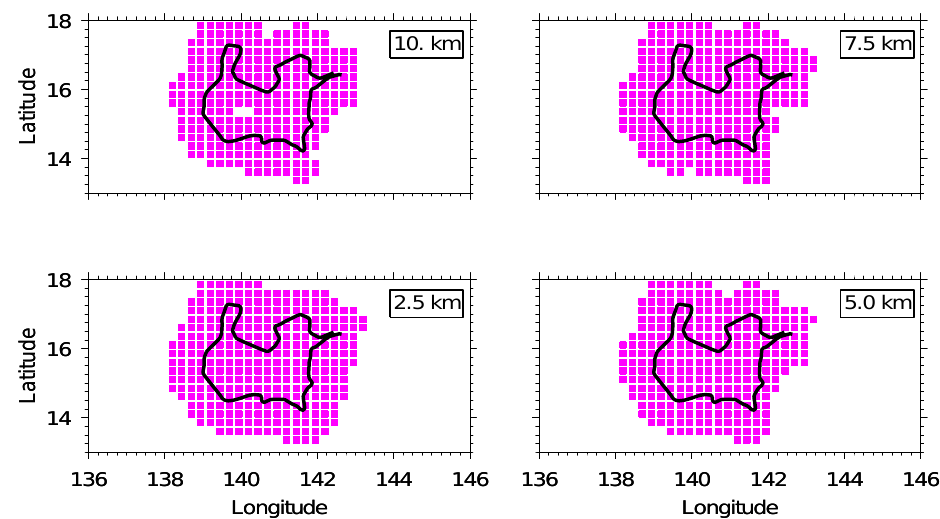
Fig. 5. Same as in Fig. 3, but for the error associated with the component of the gridded velocity along the eigen-direction with the largest eigenvalue. This plot shows that the error associated with the largest eigenvalue is always between one and two ms − 1